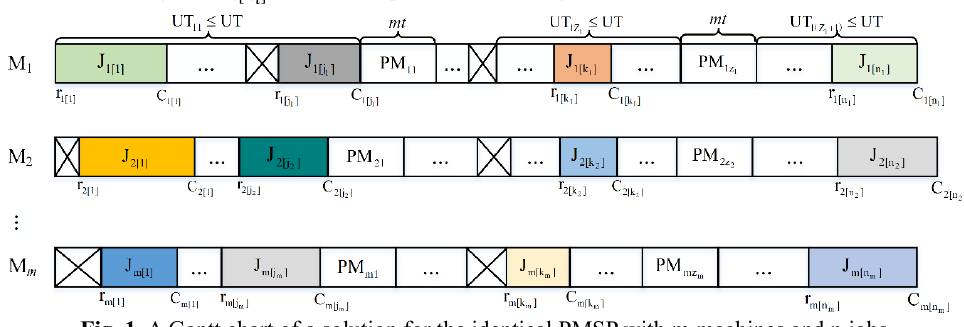
Fig. 1. A Gantt chart of a solution for the identical PMSP with m machines and n